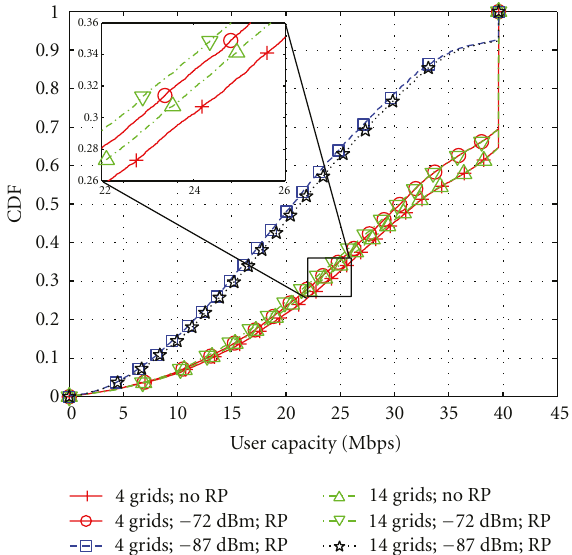
Figure 8: CDFs showing downlink user capacity only for a ff ected macro UEs for a system with resource partitioning compared against a system without resource partitioning.